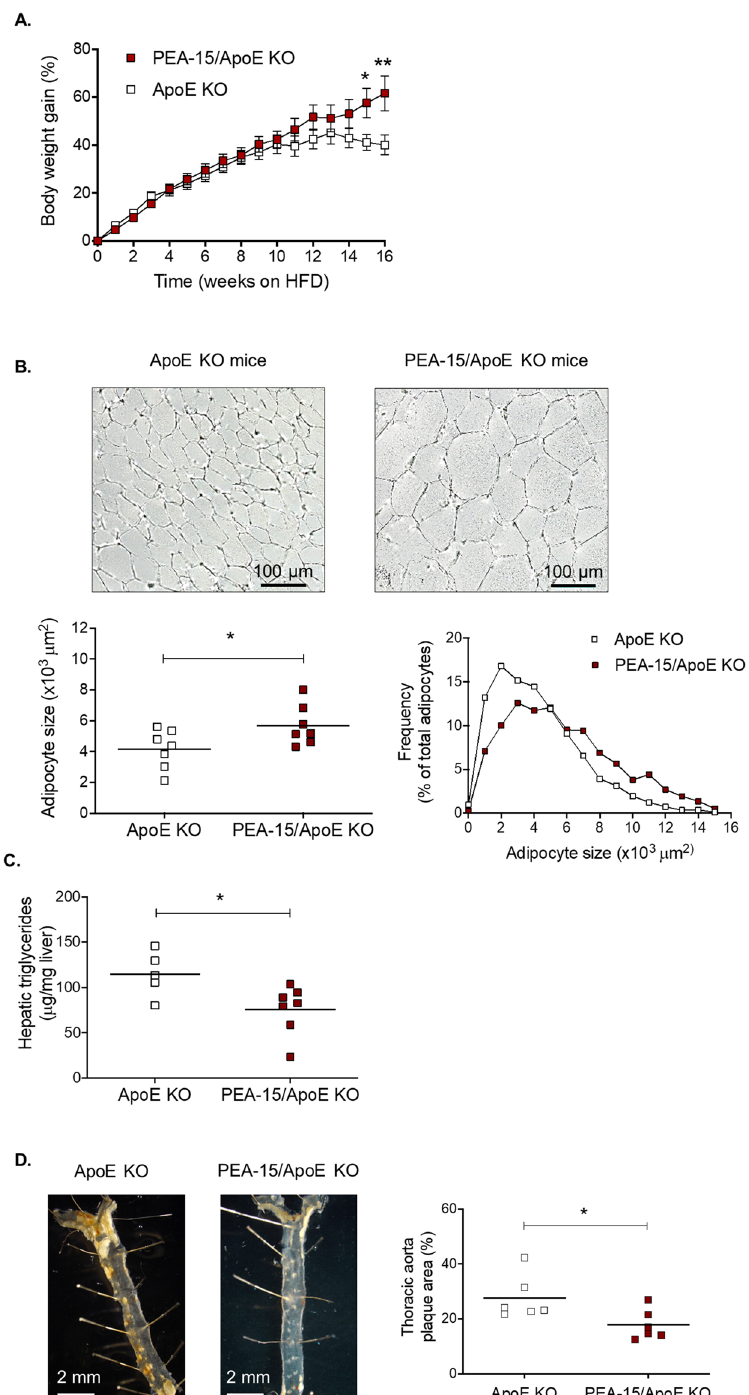
Figure 5. Characterisation of PEA-15/ApoE knockout (KO) mice. ( A ) Body weight gain of ApoE KO mice (n = 7) and PEA-15/ApoE KO mice (n = 11) during the period of the HFHC diet. Graph displays body weight gain as percentage of start weight before experiment. All data are presented as the mean ± SEM. Significant difference between the 2 groups is indicated by *P < 0.05 and **p < 0.01 using two-way ANOVA and Bonferroni post hoc test. ( B ) Representative bright field images of cross-sections of unstained eWAT. Graph displays adipocyte size measurements, significant difference between ApoE KO and PEA-15/ApoE KO is indicated by *p < 0.05 using Student t test, n = 7. ( C ) Liver triglyceride levels in ApoE KO mice (n = 5) and PEA-15/ApoE KO mice (n = 7) measured in duplicate and expressed as μg per mg of lysed liver tissue, *p < 0.05 using Student t test. ( D ) Representative en face bright field images of the thoracic aortae. Graph displays the analysis of plaque area, expressed as the percentage of the aortic surface covered by lesions (yellow formations). Significant difference between ApoE KO and PEA-15/ApoE KO is indicated by *p < 0.05 using Student t test, n = 6. All data analysis and figures were produced using GraphPad Prism version 9.0.0 for Windows, GraphPad Software, San Diego, California USA, www. graph pad.